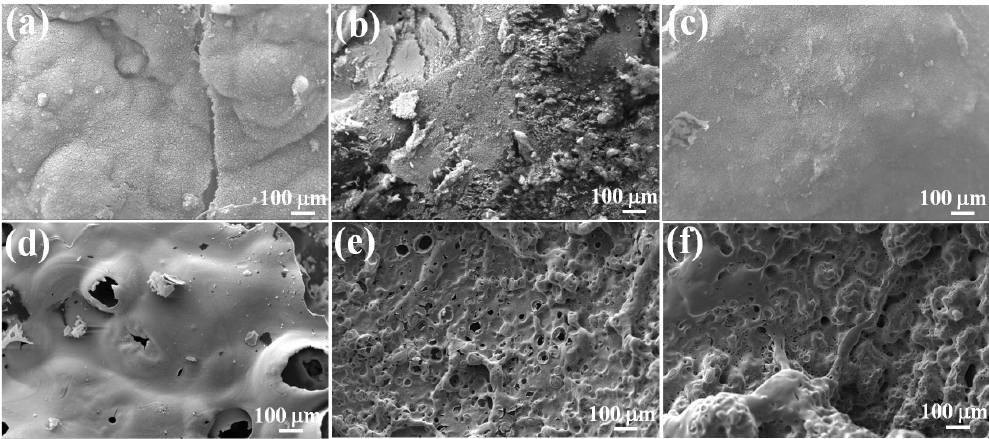
Figure 7. SEM images of the external char layers of ( a ) pure EP, ( b ) EP/2wt%LCPP,